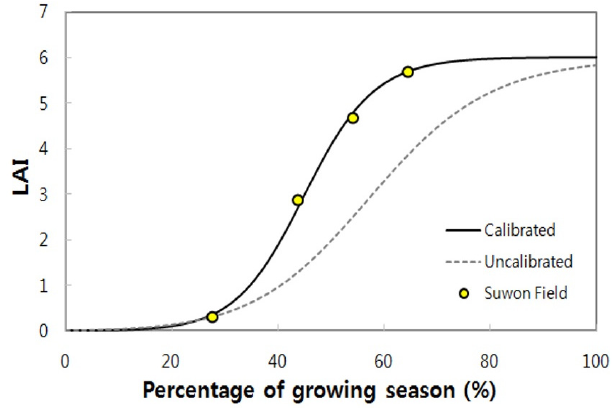
Figure 3. Calibration of the leaf area development curve. LAI in the Y ‐ axis stands for leaf area index.